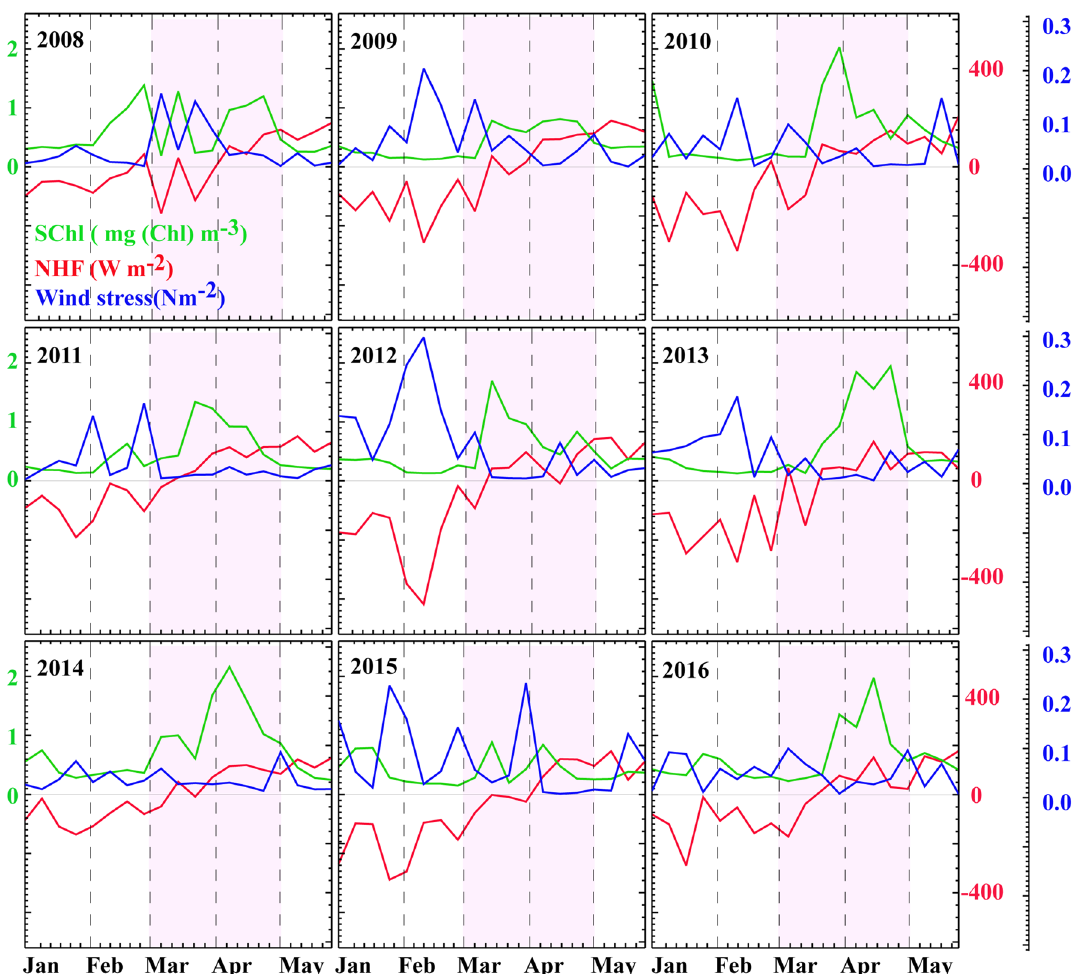
Figure 2. Timeseries of Surface Chlorophyll (SChl, green curves), Net Heat Flux (NHF, red curves) and wind stress (blue curves) averaged over the GOL box between January and May, from 2008 to 2016. The pink shading highlights the spring period